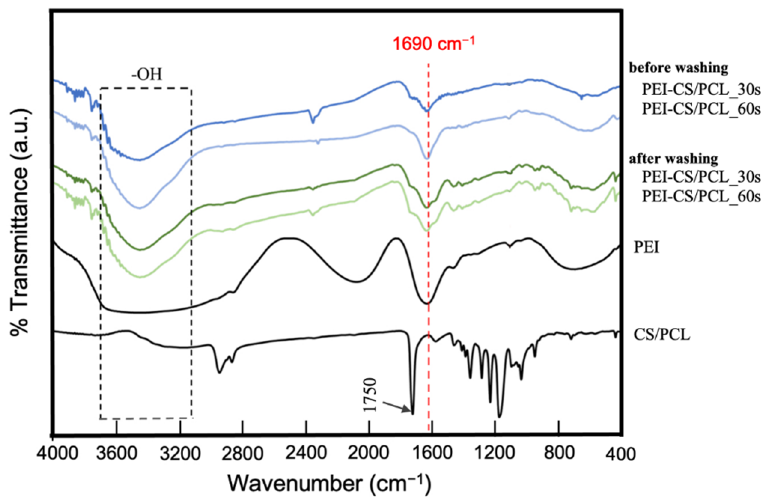
Figure 5. FT-IR spectra of CS/PCL, PEI, and PEI- CS/PCL before and after